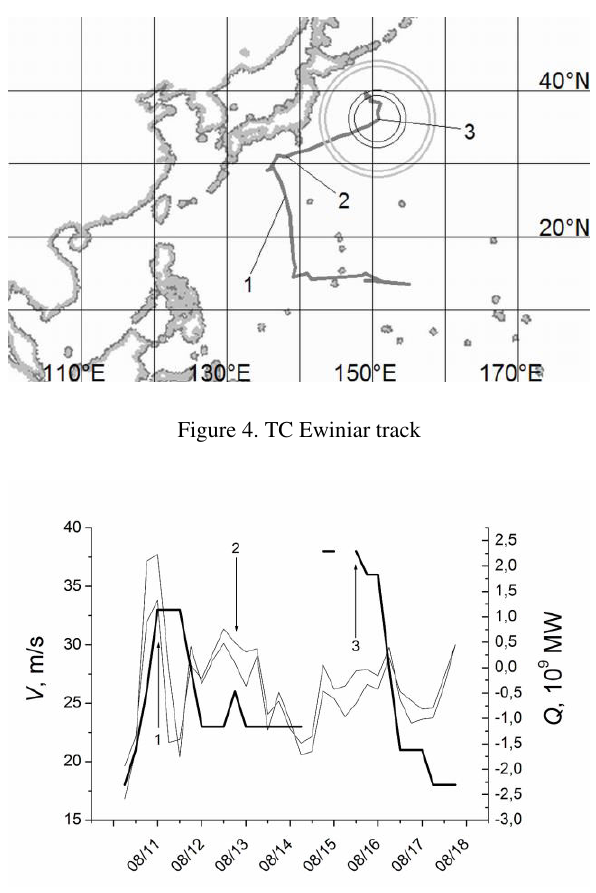
Figure 5. TC Ewiniar evolution, large contours for Q